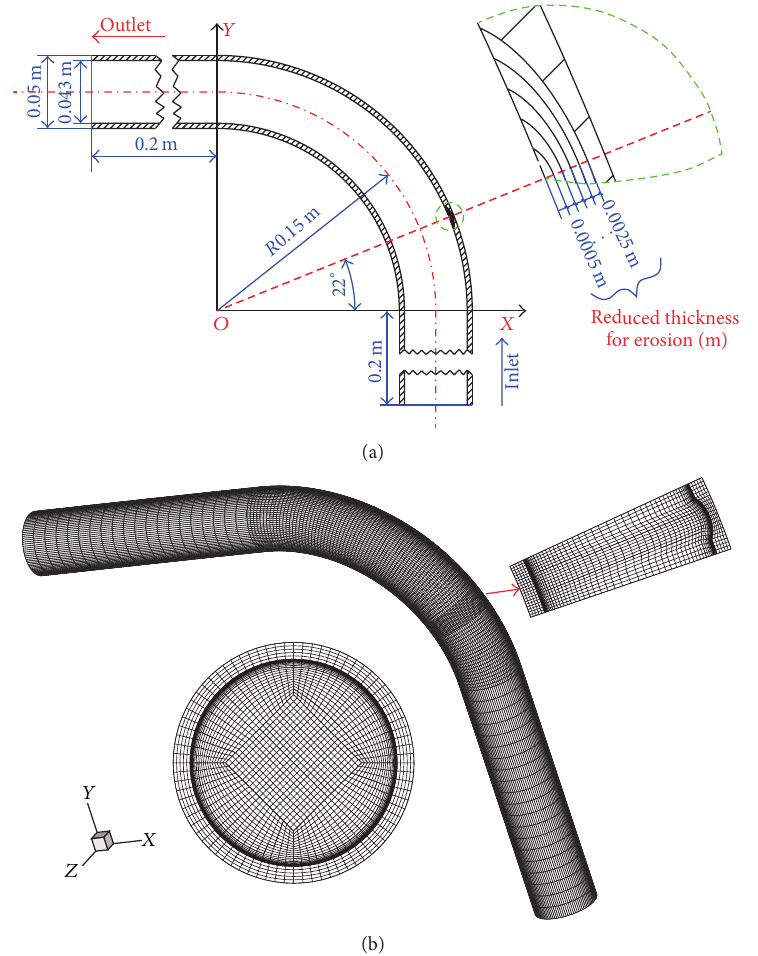
Figure 1: Sketch of the geometry and numerical grid for computational domain: (a) overall view of the computational domain and boundary conditions; (b) grid distribution of computational